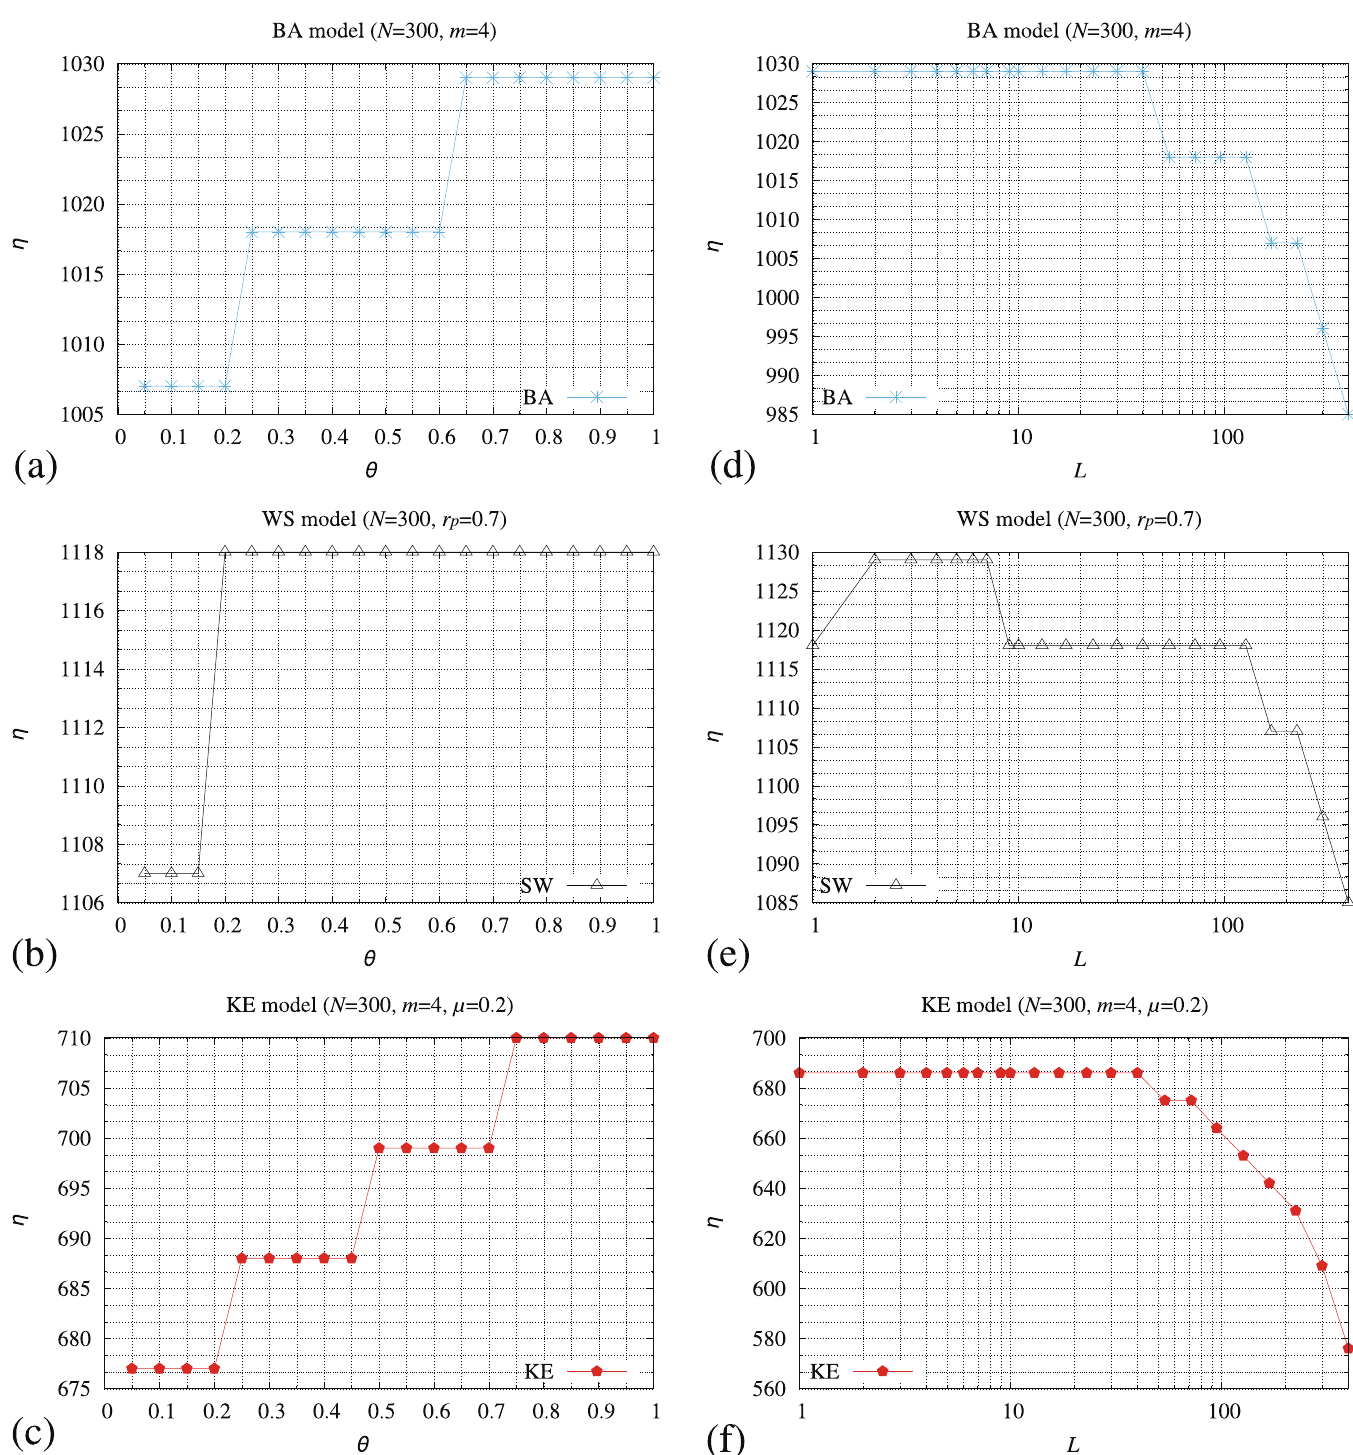
Fig 8. Relationships between a threshold ( θ ) that determines whether the adjacent nodes are congested and the maximum value of R , where A � 0.9 ( η ) of the memory-pfix method for the (a) BA, (b) WS, and (c) KE models, and relationships between a period of iterations for calculating the transmitting probability ( L ) and η for the (d) BA, (e) WS, and (f) KE models. In these simulations, we set L to 5 in (a), (b), and (c), and θ = 1.0 in (d), (e), and (f).